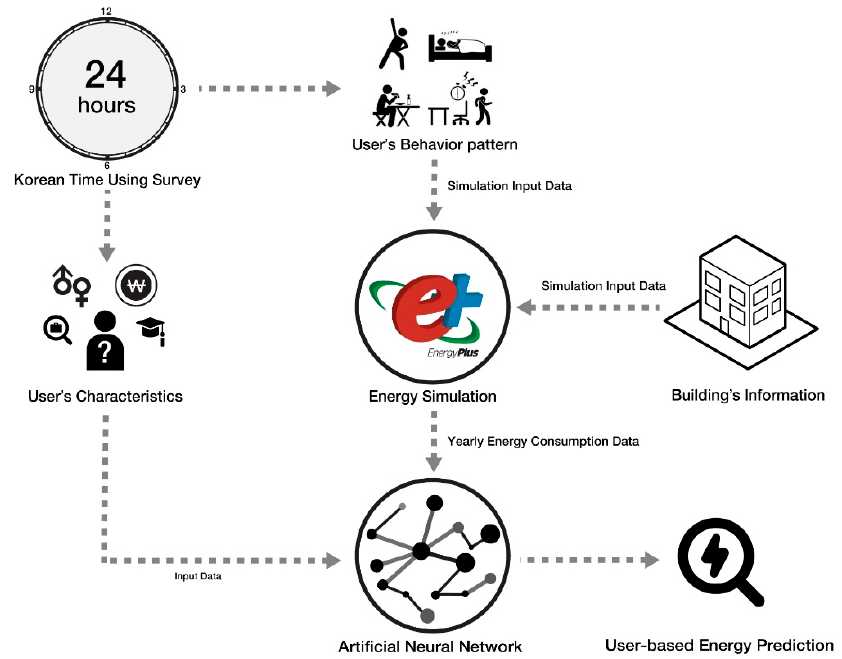
Figure 1. Flow chart depicting research process.